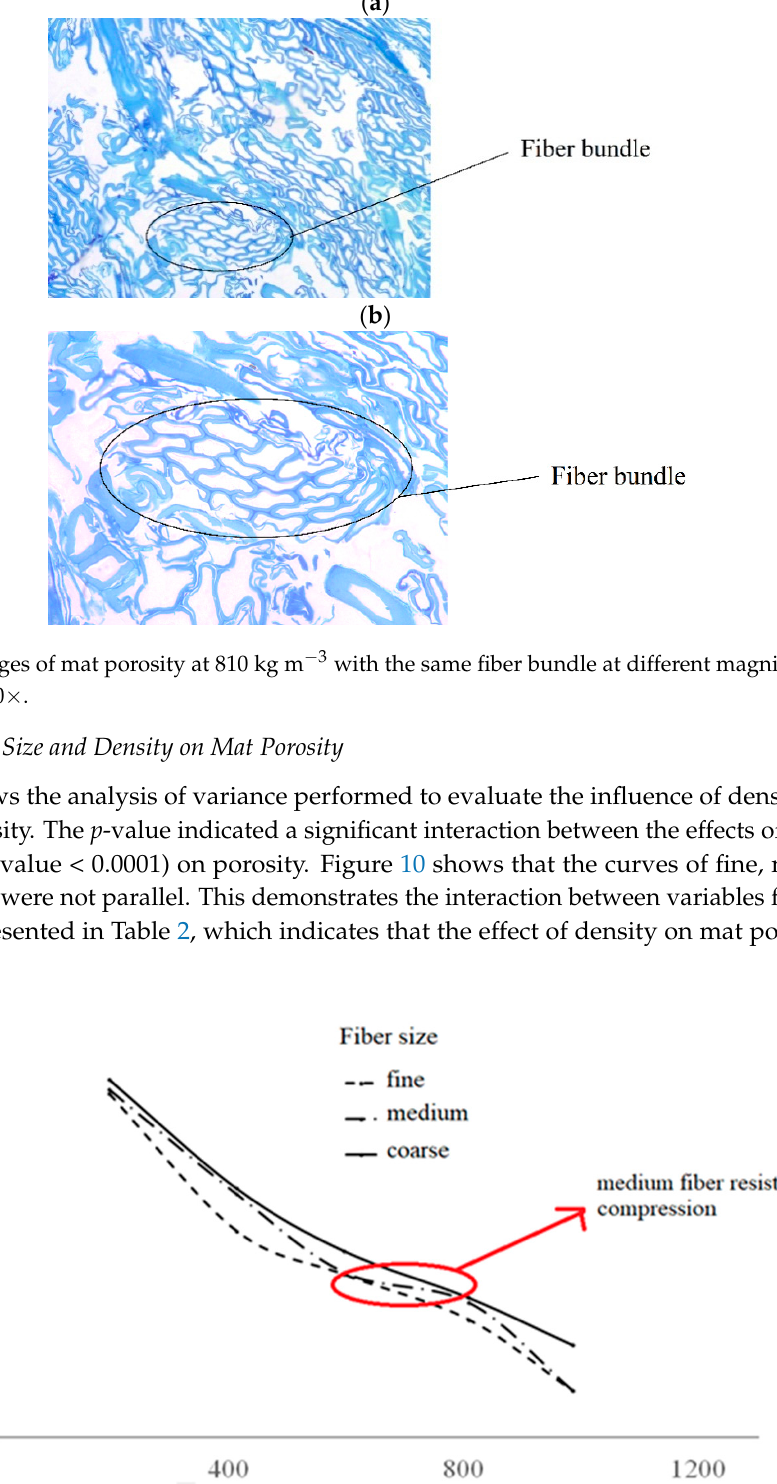
Figure 10. Interaction of mat porosity versus density at different fiber sizes.